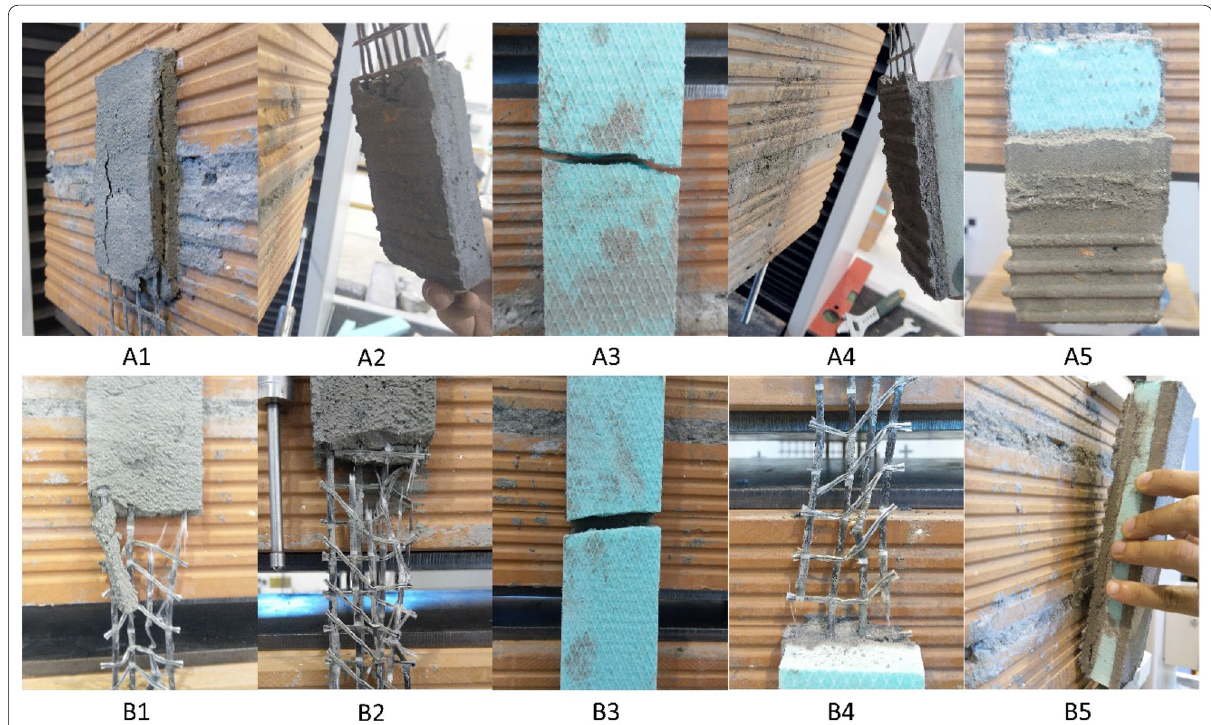
Fig. 9 Failure modes of shear bond